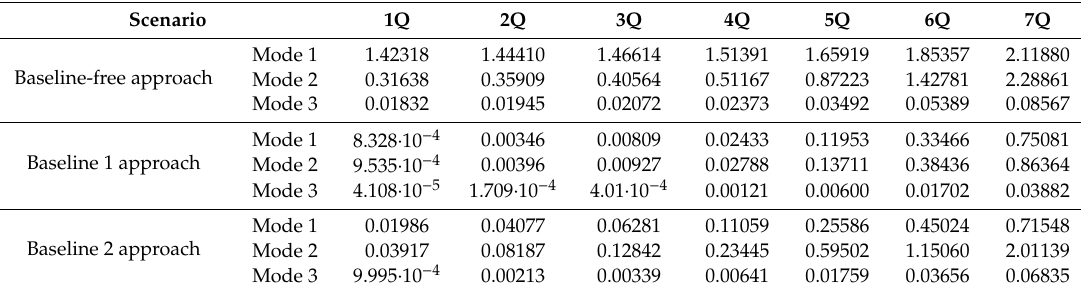
Table 3. The results of quantification of the damage depth.